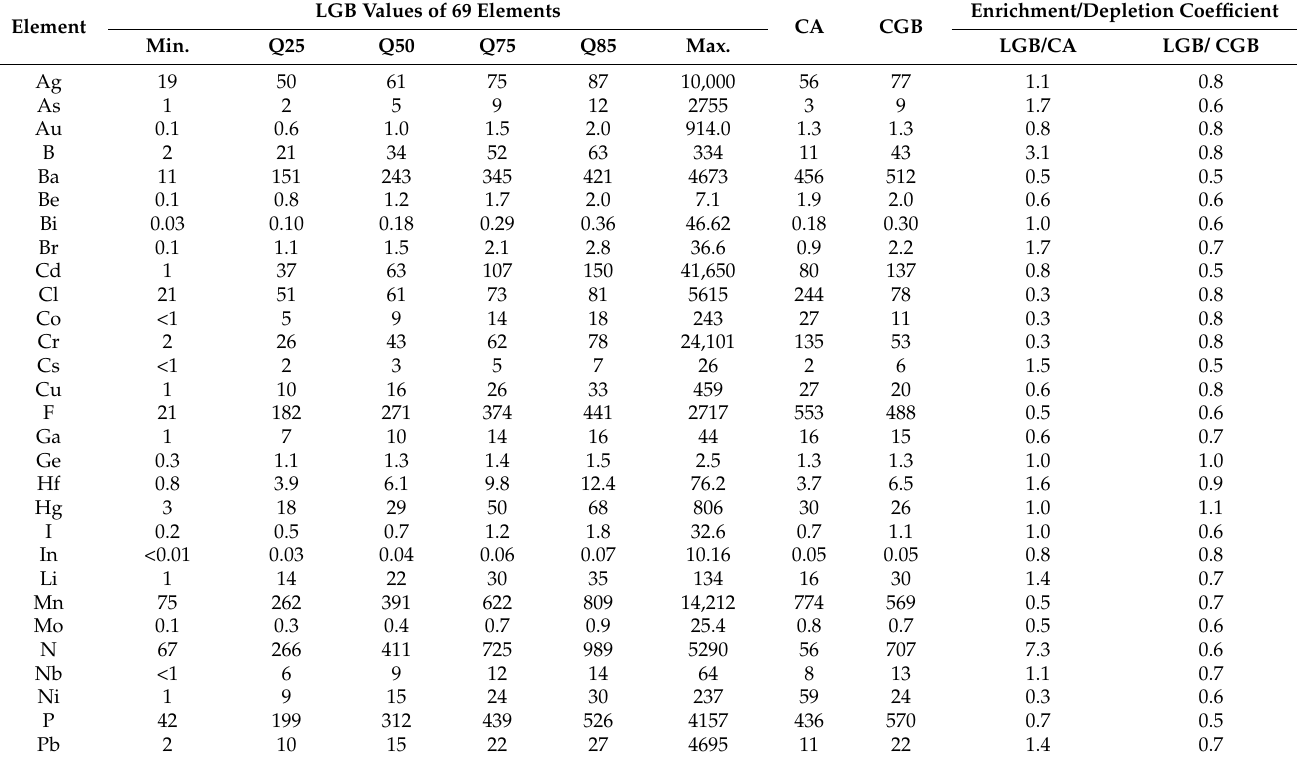
Table 3. Statistical parameters of the 69 elements and their comparisons with the CA and CGB